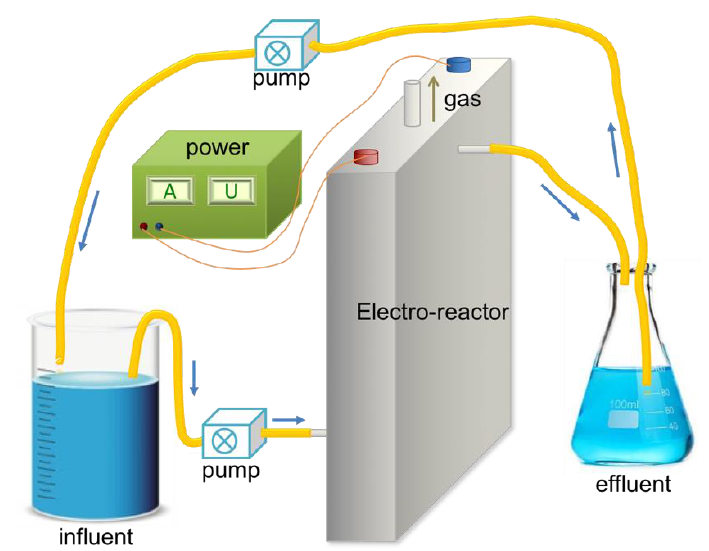
Figure 1. The virtual diagram of the recycling-flow 3D electro-reactor system.